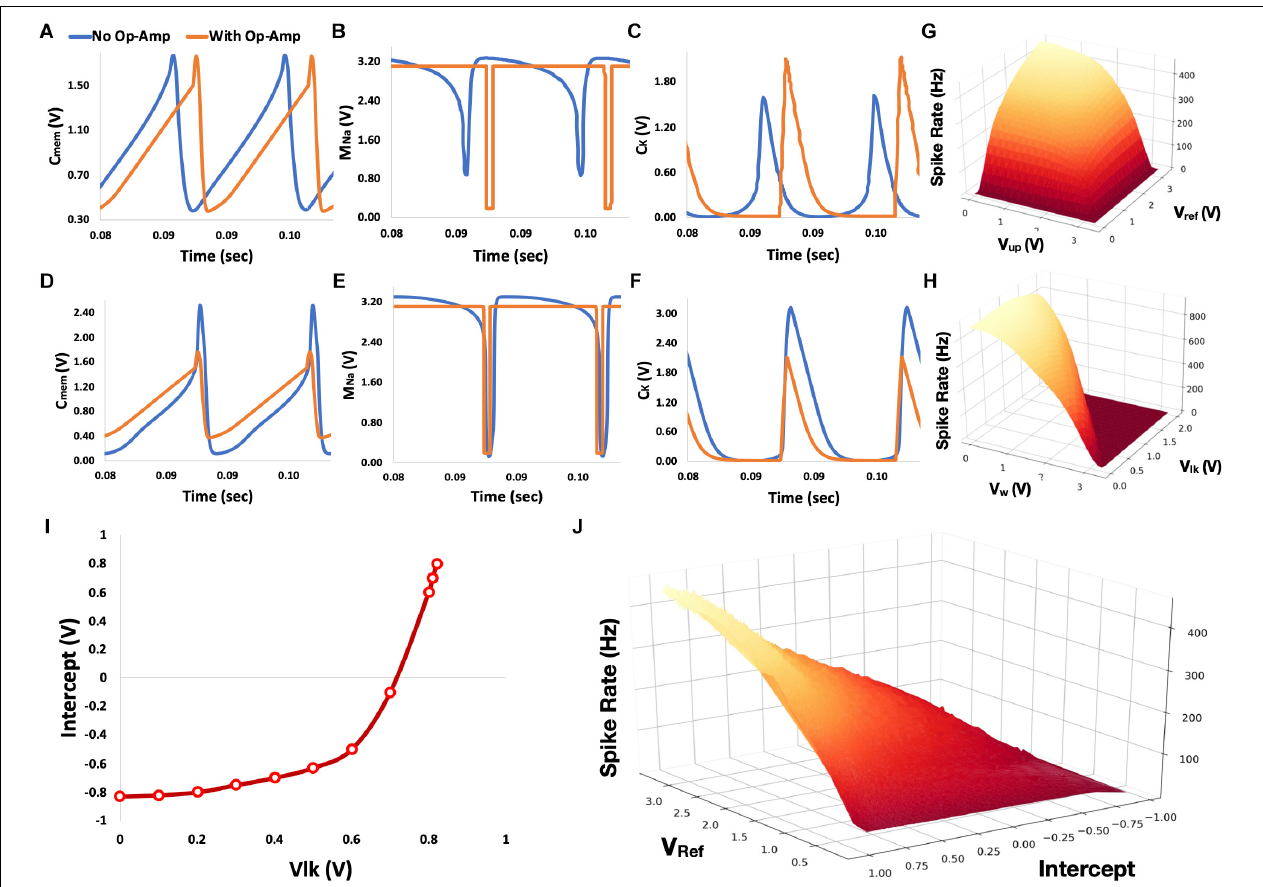
FIGURE 4 | Circuit analysis. (A–C) Voltage traces for the subthreshold first-order LPF neuron circuit with and without op-amp for spike generation (colored orange and blue, respectively). Traces for the voltages over C mem , gate of M Na , and C K are shown in panels A–C , respectively. (D–F) Similar traced to panels A–C , where the transistor-based controls of I Na and I kup were eliminated. (G) Neuron’s spike rate as a function of V ref and V up . (H) Neuron’s spike rate as a function of V w and V lk (I) Neuron’s intercept as a function of V lk . (J) For a given intercept (determined by V lk ), a neuron’s spiking rate can be determined by V ref . V w was held constant at 2.4 V for both I and J